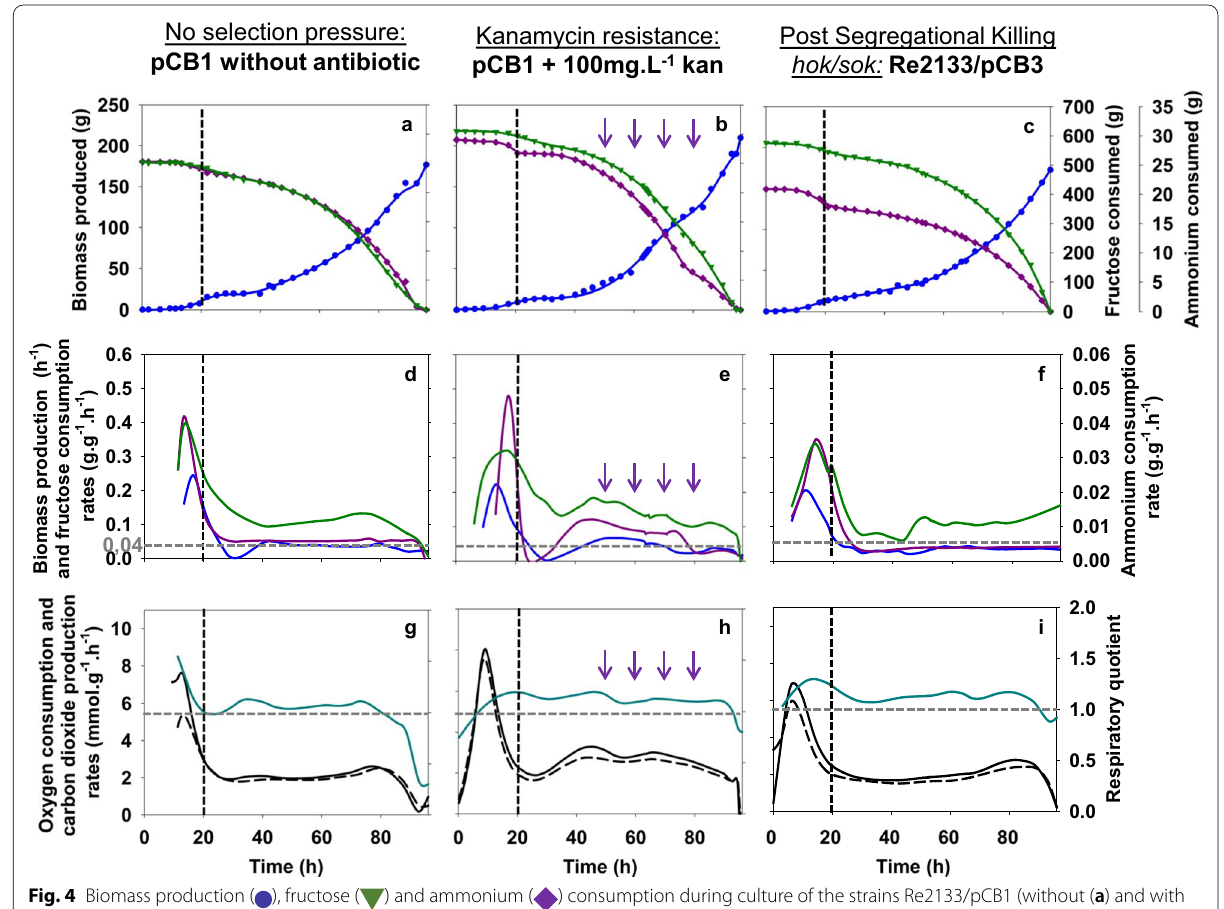
Fig. 4 Biomass production ( ), fructose ( ) and ammonium ( ) consumption during culture of the strains Re2133/pCB1 (without ( a ) and with kanamycin ( b ) and pCB3 ( c )). Growth rate ( ), fructose ( ) and ammonium ( ) consumption rates during Re2133/pCB1 culture of the strains Re2133/pCB1 (without ( d ) and with kanamycin ( e )) and pCB3 ( f )). Respiratory quotient ( ), oxygen consumption ( ) and carbon dioxide ( ) production rates during culture of the strains Re2133/pCB1 (without ( g ) and with kanamycin ( h ) and pCB3 ( i )). Black vertical lines represent the beginning of the fed-batch phase and purple arrows represent additions (kanamycin, 100 mg L − 1 ; elements and phosphorus ·